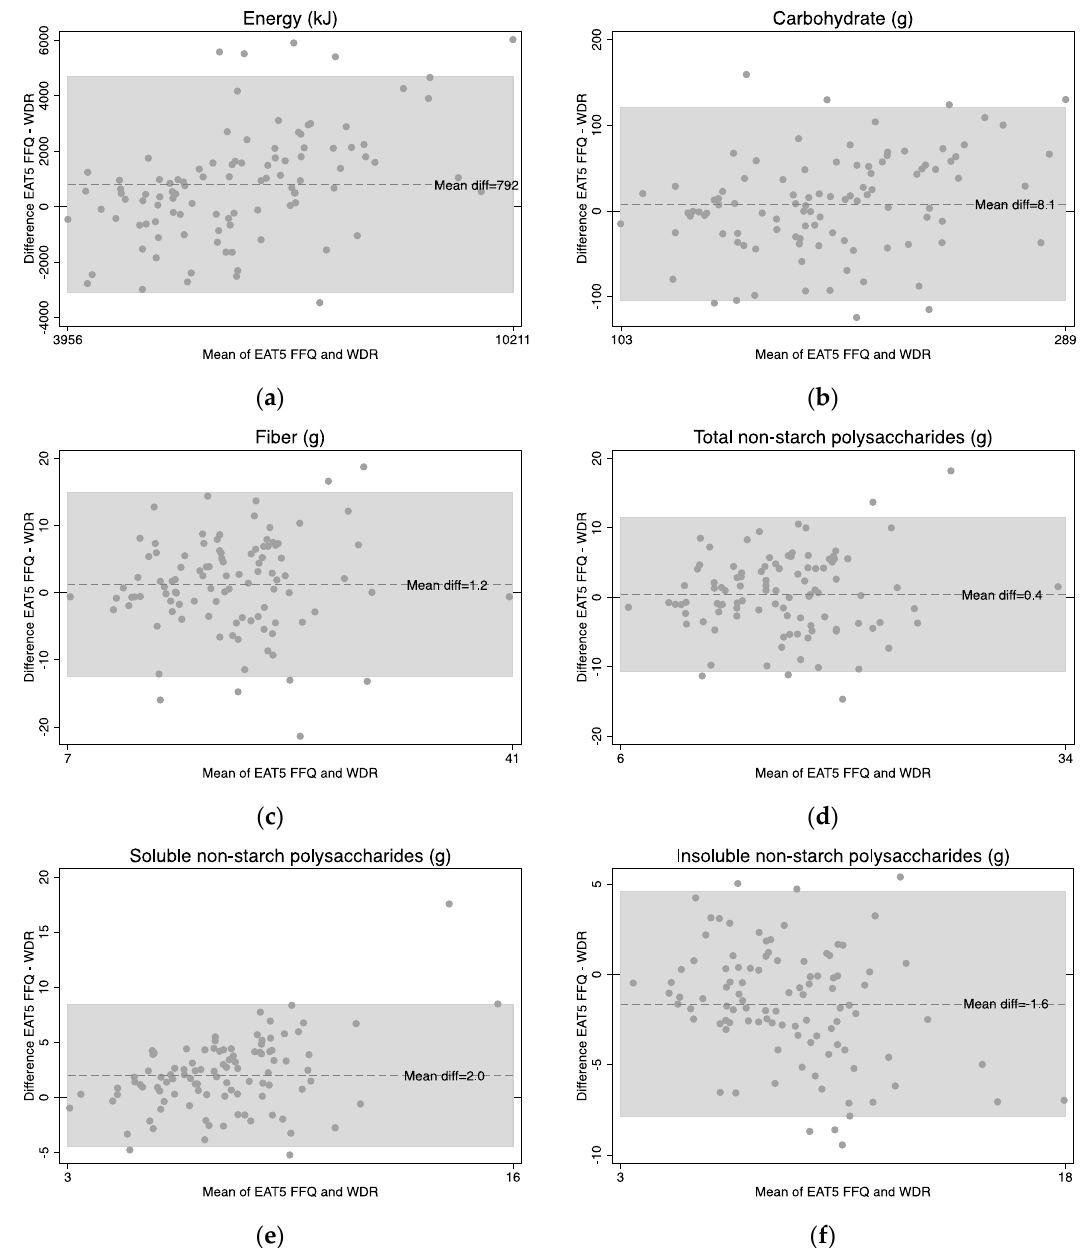
Figure 2. Bland-Altman plots for nutrient intakes from a randomly chosen FFQ1 or FFQ2 EAT5 FFQ (‘fruit and vegetable adjusted’) and the weighed diet record (WDR): ( a ) Energy in kJ; ( b ) Carbohydrate in grams; ( c ) Fiber in grams; ( d ) Total non-starch polysaccharides in grams; ( e ) Soluble non-starch polysaccharides in grams; and ( f ) Insoluble non-starch polysaccharides in grams.